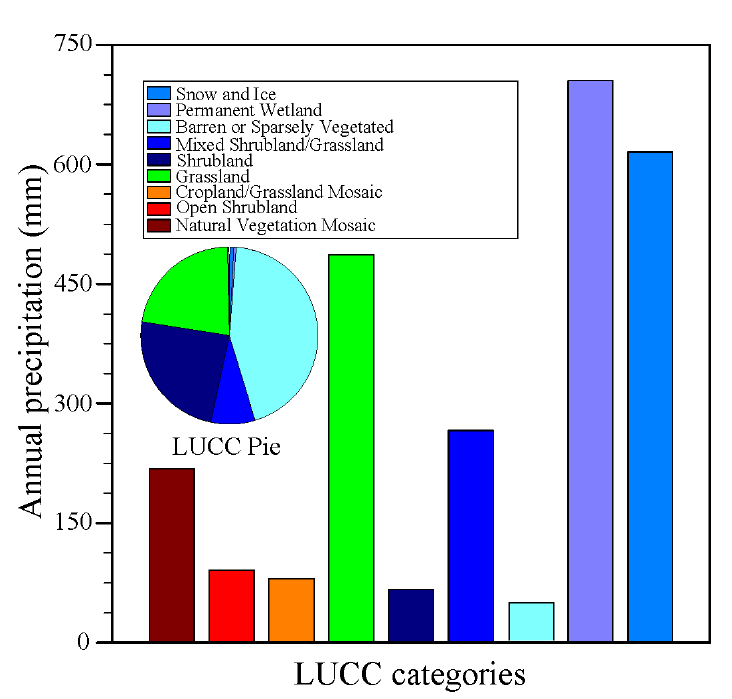
Figure 5. The average annual precipitation for different land use and cover change (LUCC) categories in the HRB from 2000 to 2013